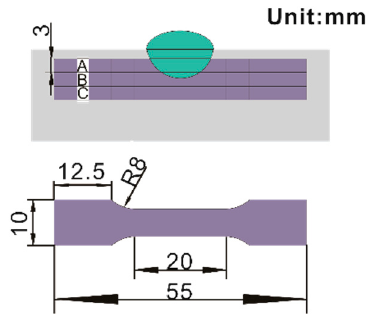
Figure 4. Sampling position and dimensions of tensile samples.